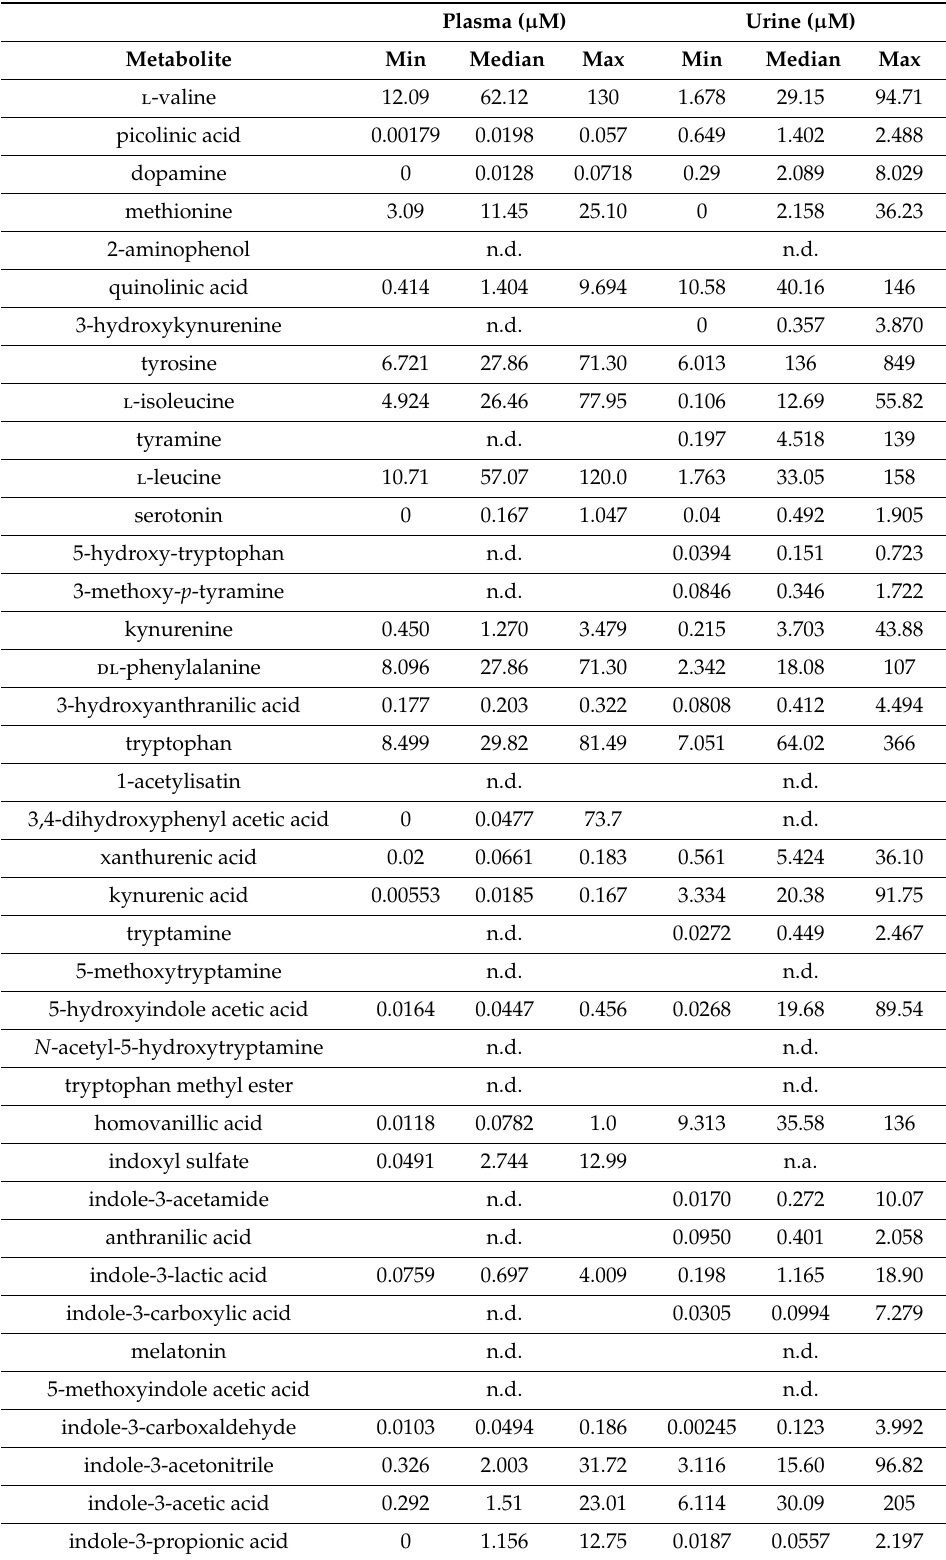
Table 2. Metabolite concentration ranges ( µ M) detected in plasma and urine. n.d.: not detected; n.a.: data not